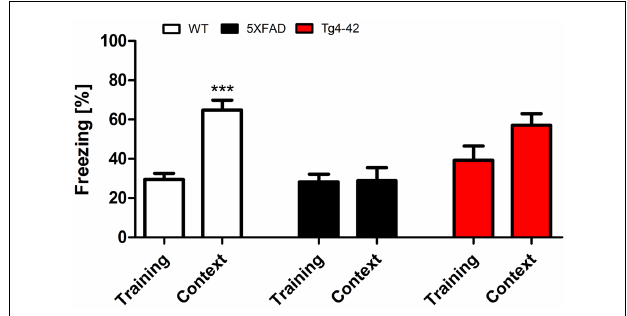
FIGURE 3 | Impaired contextual conditioning inTg4–42 and 5XFAD mice . Aged 5XFAD,Tg4–42, andWT mice were trained with a CS/US pairing for contextual fear conditioning ( n = 11–13). Mice were reintroduced to the original training context (CS) 24h post training and tested for contextual memory. Levels of freezing during the re-exposure were not different from the training trial for 5XFAD andTg4–42. In contrast,WT mice showed a significant increase on freezing response to the context. CS = conditioned stimulus. Freezing: unpaired t -test; *** p < 0.001.